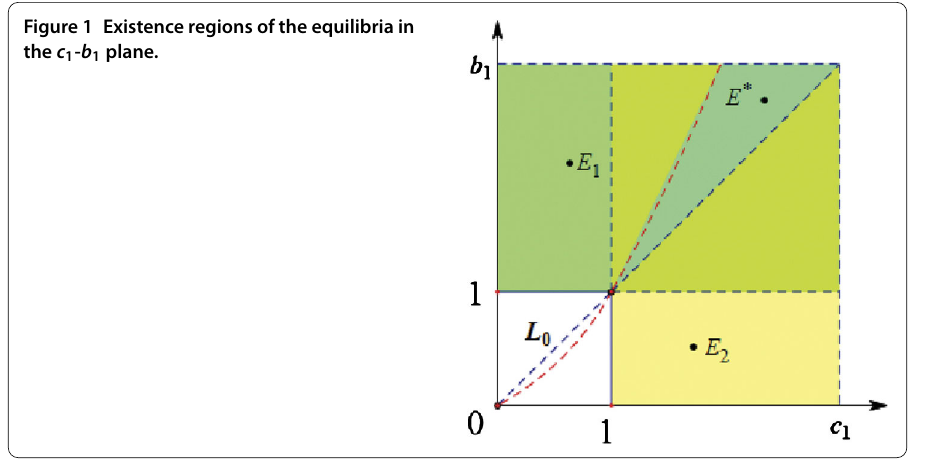
Figure 1 Existence regions of the equilibria in the c 1 - b 1